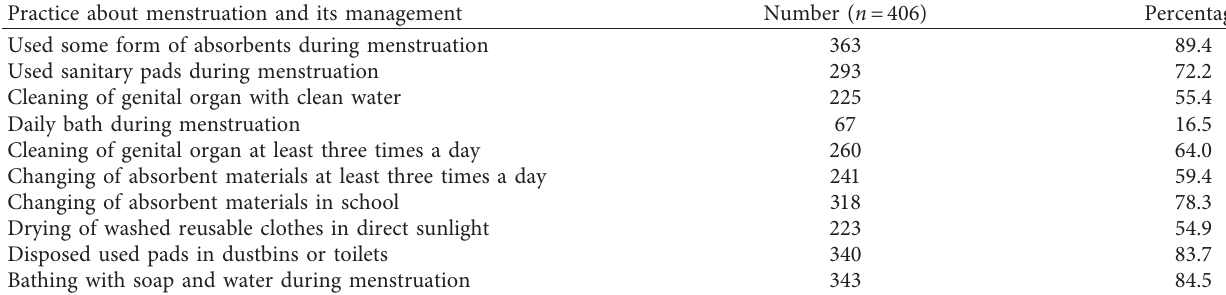
Table 2: Distribution of practice of adolescent school girls about menstruation hygiene and its management.